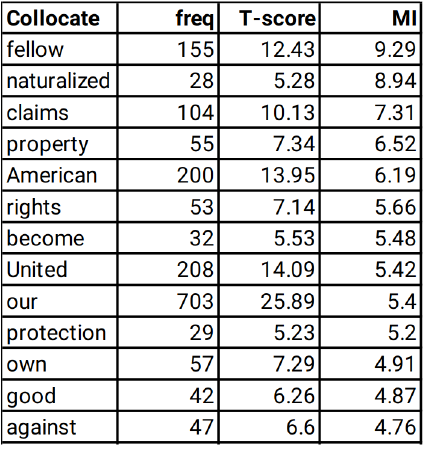
Table 2. Top collocates of citizens in the SoU